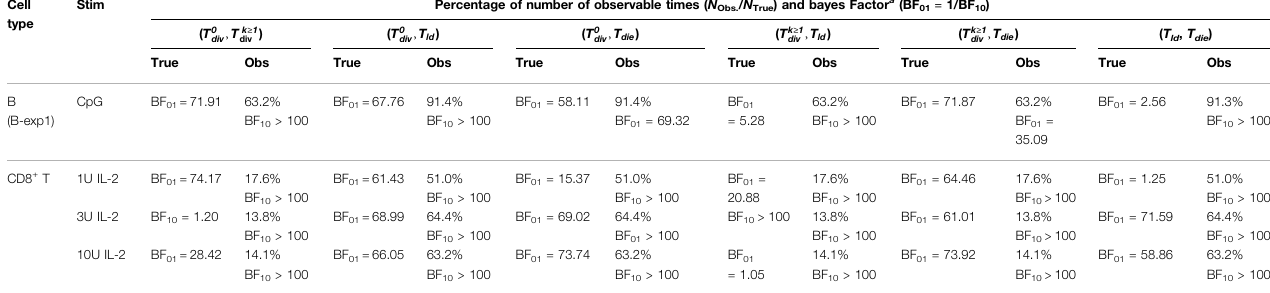
TABLE2| Bayesianindependencetestofthetimestofatesfromsimulation.Thetestwasperformedwith N True (cid:2) 10 6 simulatedfamilies via Cyton2-likeAgent-Based Model. Each family wasassignedrandomly sampled times (True),and corresponding observable(Obs.)times wererecorded. Depending onthe orderofthe true times tofates, the number of observable times ( N Obs. ) may vary. For both true and observable times, Bayes Factor (BF) was calculated given null and alternative hypotheses (H 0 : ρ (cid:2) 0 and H 1 : ρ ≠ 0). Here BF 01 indicates the simulated data are more probable under H 0 , otherwise it is indicated by BF 10 . Cell Percentage of number of observable times ( N Obs. / N True ) and bayes Factor a (BF 01 = 1/BF 10 ) type